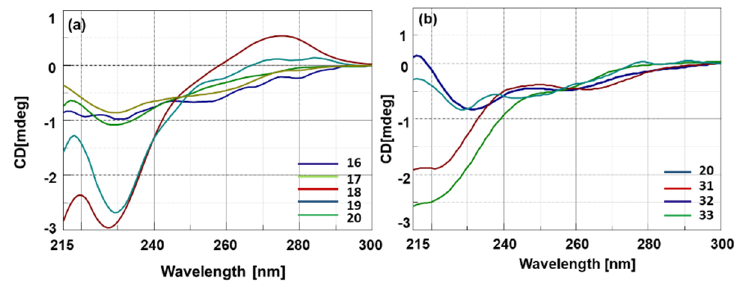
Figure 1. CD spectra of 16 - 20 ( a ) and 20 , 31 - 33 ( b ) nucleopeptides.